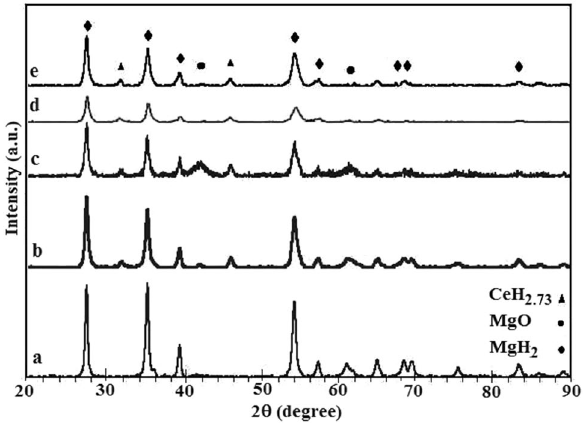
Fig. 6 The XRD pattern of a 10 h ball-milled MgH MgH 2 -6wt % of mischmetal ball-milled for b 10 h, c 20 h, d 30 h, and